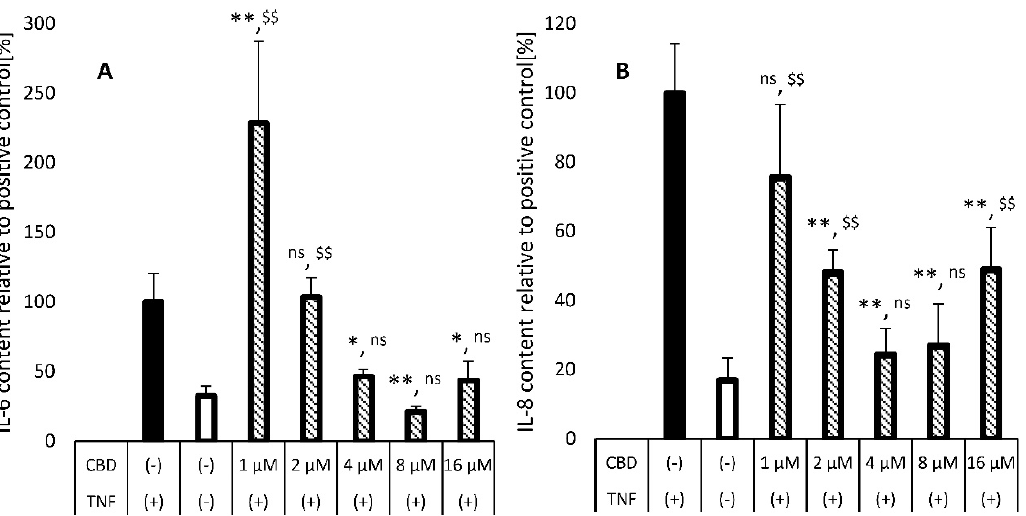
Figure 7. IL-6 ( A ) and IL-8 ( B ) secretion from TNF- α -induced inflamed HaCaT cells treated with various concentrations of CBD. The first two columns (filled and blank bars) represent CBD-free control groups with and without TNF- α induction. * indicates comparison to the positive control TNF(+). $$ indicates comparison to the negative control TNF( − ). * p value < 0.05, **/ $$ p value < 0.01, ns—no significant difference between compared groups. The p values were calculated by one-way ANOVA, followed by the Tuckey test. Values are presented as mean ± SD.